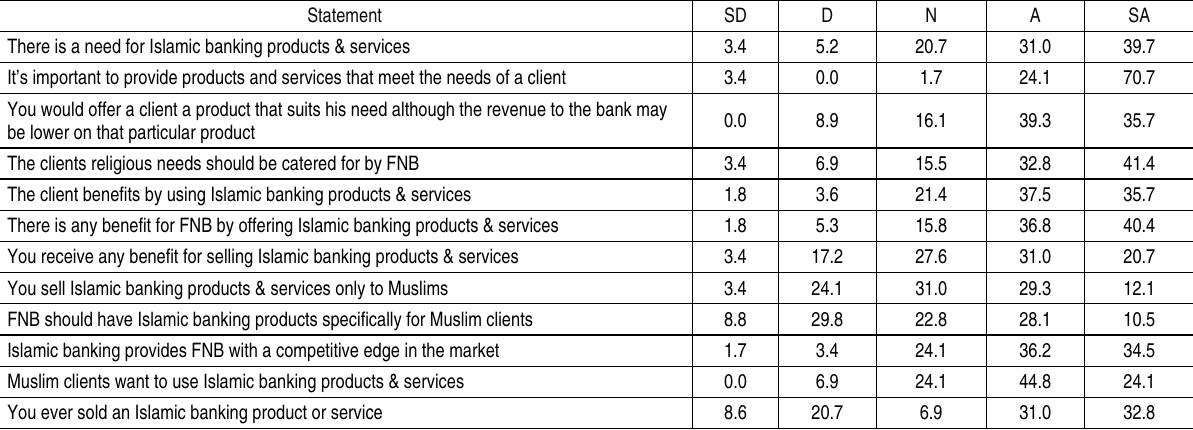
Table 1. Perception regarding Islamic banking products and